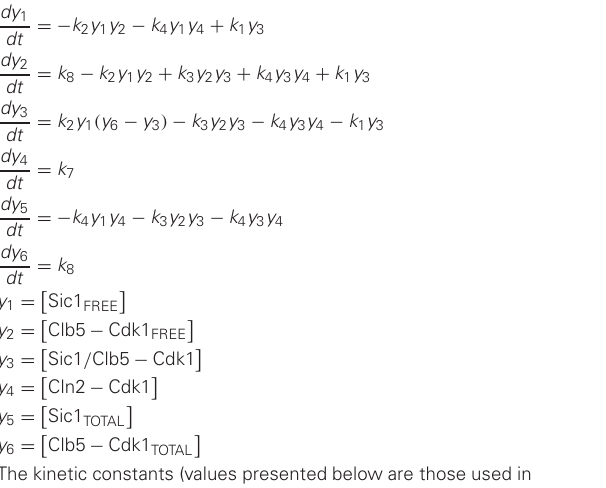
Table 2 | Equation system used for numerical simulation of the time courses at G1/S in Figures 8A–C, 9A–D, and